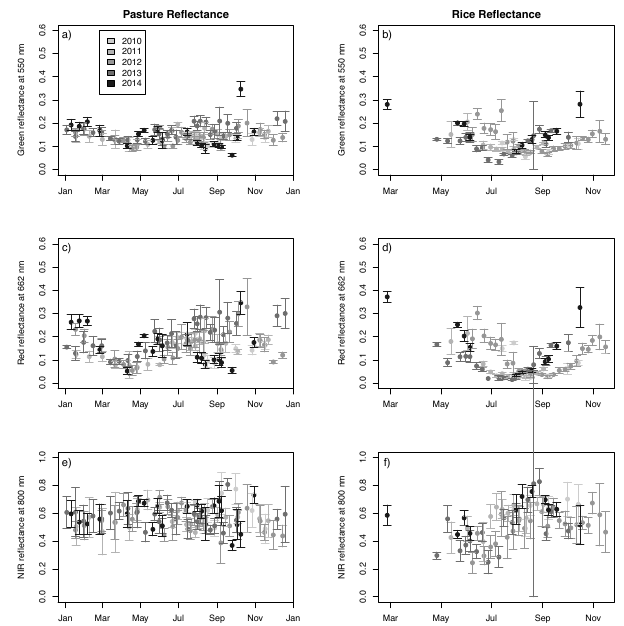
Figure 4. Interannual and daily variability at narrow-band green, red, and near-infrared (NIR) reflectance. (a–b) Interannual variabil- ity in measured canopy green reflectance at 550 ± 5nm, where the points are the site mean and the bars represent one standard devia- tion for each sampling date. The green reflectance at the Pasture was relatively uniform throughout the year, due to the presence of either grass or pepperweed canopy for most of the year. There was more intra-site variability in reflectance during the summer when the pep- perweed canopy was active, since at some locations the white flow- ers of the pepperweed plant can complicate the green reflectance spectrum. The green reflectance at the Rice had more interannual variability but a more discernible seasonal pattern within each year, where the trough in green reflectance tended to occur mid-summer. (c–d) These plots show red reflectance at 662 ± 5nm at each site, which corresponds to the absorption wavelength of chlorophyll b . Both sites demonstrated a seasonal pattern, where the minimum in red reflectance occurred in late spring at the Pasture and in late sum- mer at the Rice, corresponding to the times of peak plant growth at each site. Again, the Pasture had more intra-site variability, partic- ularly during the summer months when pepperweed is active. (e– f) Here we plot the near-infrared (NIR) reflectance at 800 ± 5nm for the two sites. NIR reflectance at the Pasture had no strong seasonal pattern, with a constant mean throughout the year and across years. The rice demonstrated a stronger pattern across the season, with less NIR reflectance early in the growing season when the canopy was developing, with higher NIR reflectance as the crop achieved a full canopy later in the summer. At both sites, intra-site variabil- ity in NIR reflectance was much higher than the variability in the reflectance in the visible